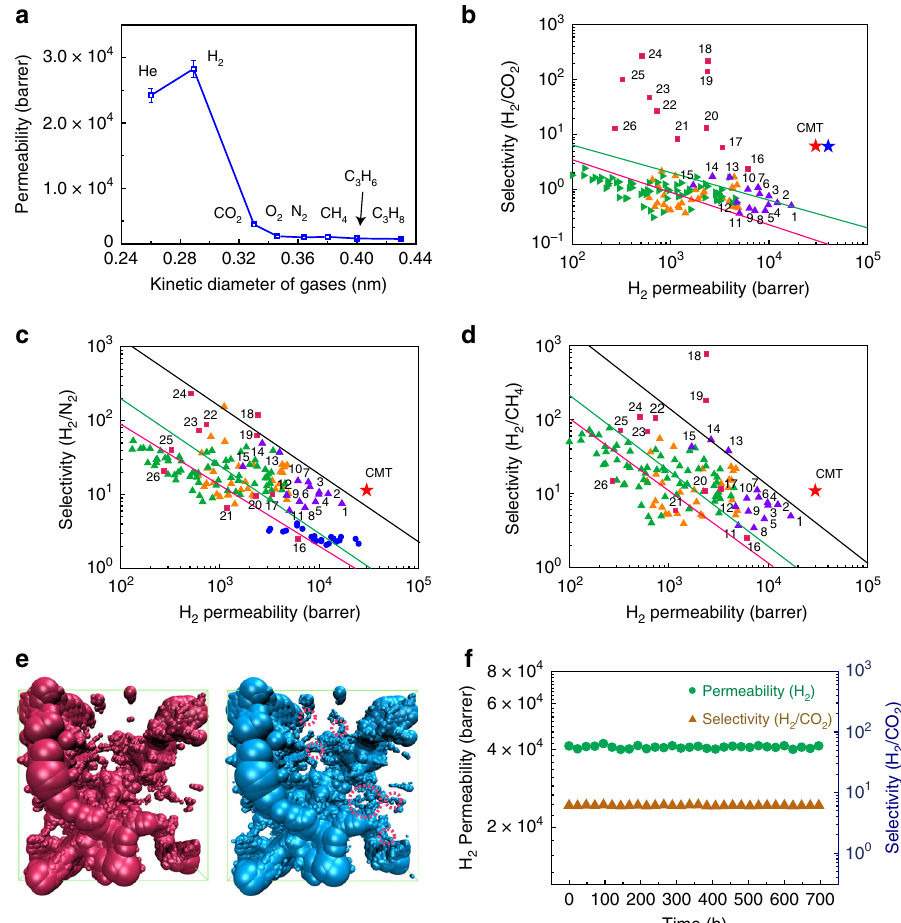
Fig. 3 Gas separation performance of CMT membranes. a Single-gas permeabilities (He, H 2 , CO 2 , O 2 , N 2 , CH 4 , C 3 H 6 , and C 3 H 8 ) through a 1- μ m-thick CMT membrane at 30 °C and a transmembrane pressure of 1 bar. b – d Robeson plots for H 2 /CO 2 , H 2 /N 2 , and H 2 /CH 4 gas pairs with the 1991 upper bounds indicated by a pink line, 2008 upper bounds by a green line and proposed 2015 upper bounds by a black line. The single-gas permeation data of CMT membrane (red star) is compared with accumulated literature data for state-of-the-art ultrapermeable PIMs (violet triangle), microporous solids (zeolites, MOFs, POPs) and inorganic 2D materials (red square), and other polymers (ladder PIMs: orange triangle; PIM-PIs: green triangle; ultrapermeable poly(trimethylsilylpropyne) (PTMSP): blue circle). Information on the data points and their corresponding references are presented in Supplementary Table 2. e Accessible void spaces for CO 2 (left) and H 2 (right) in CMT model; The red circles in the right picture indicate additional accessible void spaces for H 2 , compared with that of CO 2 . f Long-term test of an equimolar H 2 /CO 2 mixed-gas mixture through a 1- μ m-thick CMT membrane at 150 °C and a transmembrane pressure of 1 bar. The blue star in b indicates the permeation data from H 2 /CO 2 mixed-gas measurement at 150